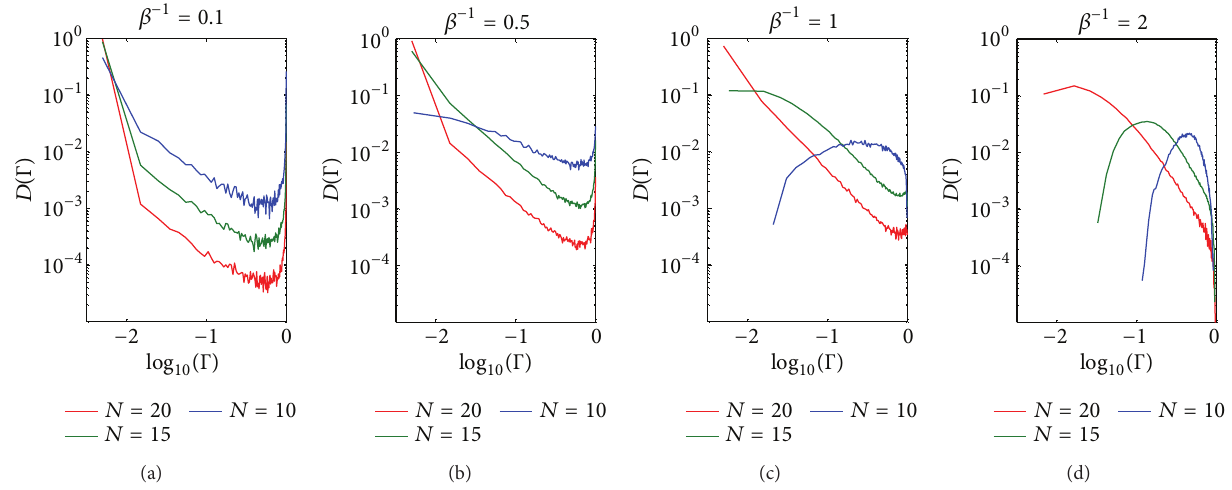
Figure 5: Distribution of Γ , 𝐷(Γ) , for various 𝑁 for an Ising-Glauber spin lattice with antiferromagnetic RKKY interactions. Different temperature dependent 𝐷(Γ) is shown for (a) 𝛽 −1 = 0.2 , (b) 𝛽 −1 = 0.5 , (c) 𝛽 −1 = 1 , and (d) 𝛽 −1 = 5 . 𝐷(Γ) is normalized over 2 𝑁 column entries and then averaged over 256 equally spaced columns.